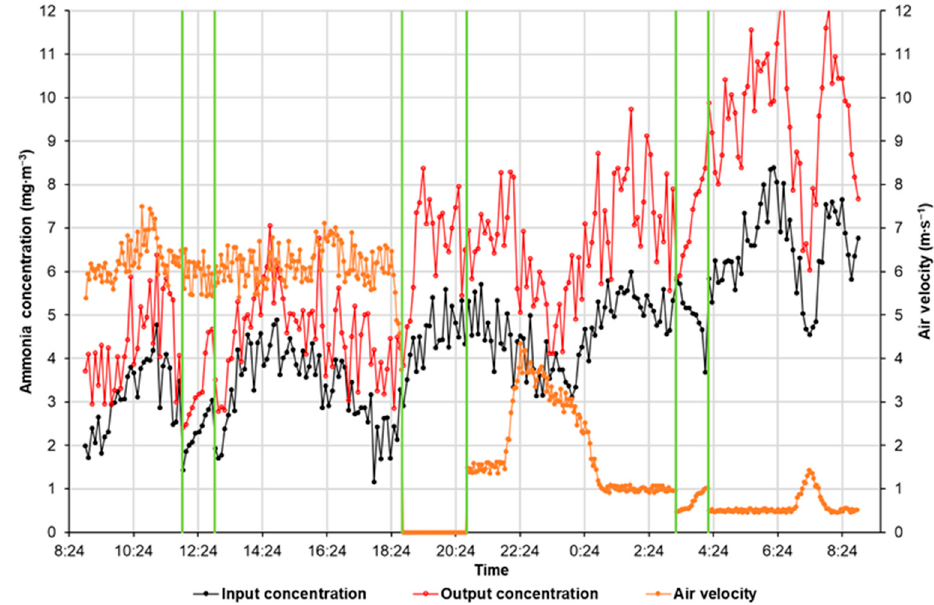
Figure 5. Creation of model values with randomly modified time intervals (three green gaps).